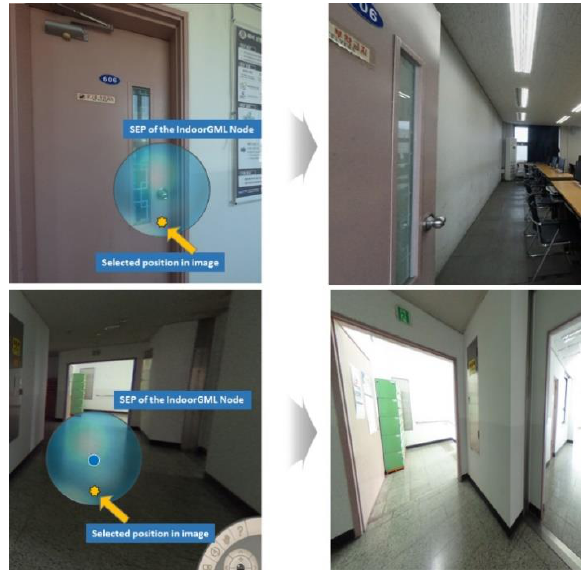
Figure 14. Visualization of omnidirectional image upon recognition of space in current